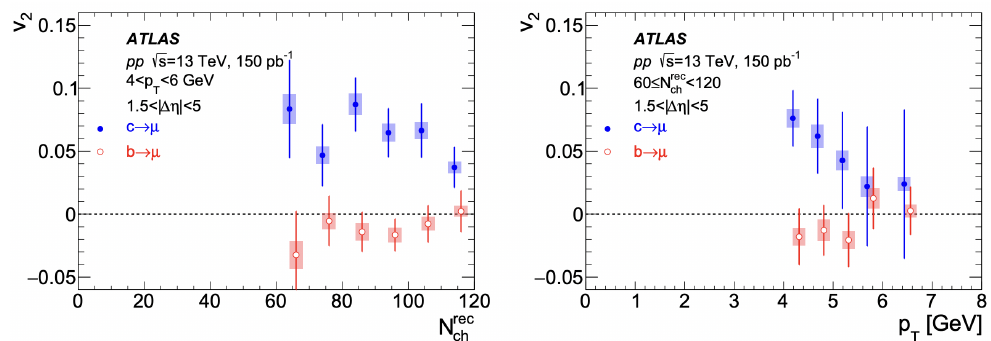
Figure 15. Elliptic flow v 2 of muons from charm quark decays (blue data points) and bottom quark decays (red data points) as a function of charged track multiplicity N rec momentum, ( right ) [80]. Measurements are taken at forward pseudorapidity 1.5 < η < 5, with transverse momentum range of 4 < p T < 6 GeV/c and charged track multiplicity 60 < N rec Reprinted with permission from American Physical